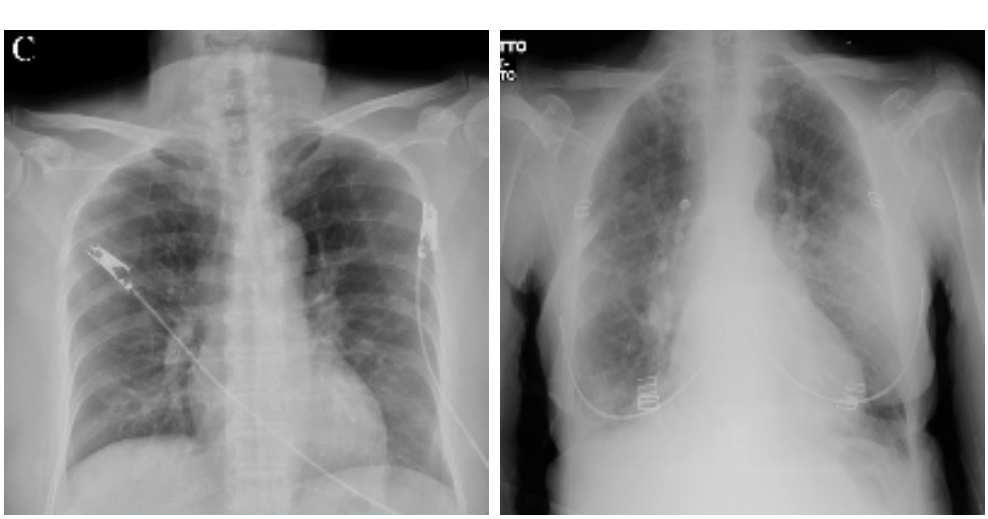
Figure 8. Examples of radiography images of patients infected with COVID-19 (positive examples).